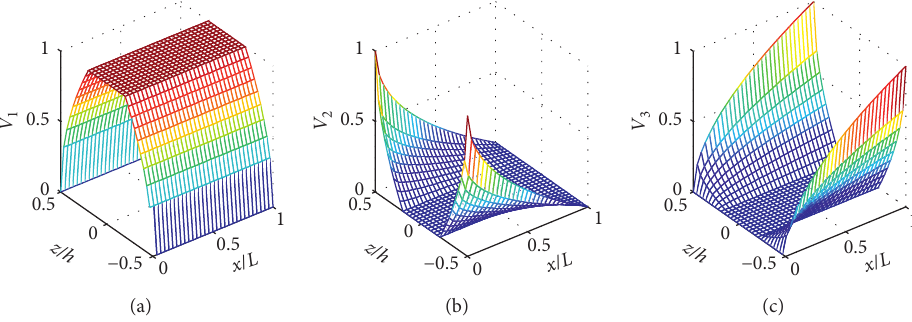
Figure 2: Distribution of V